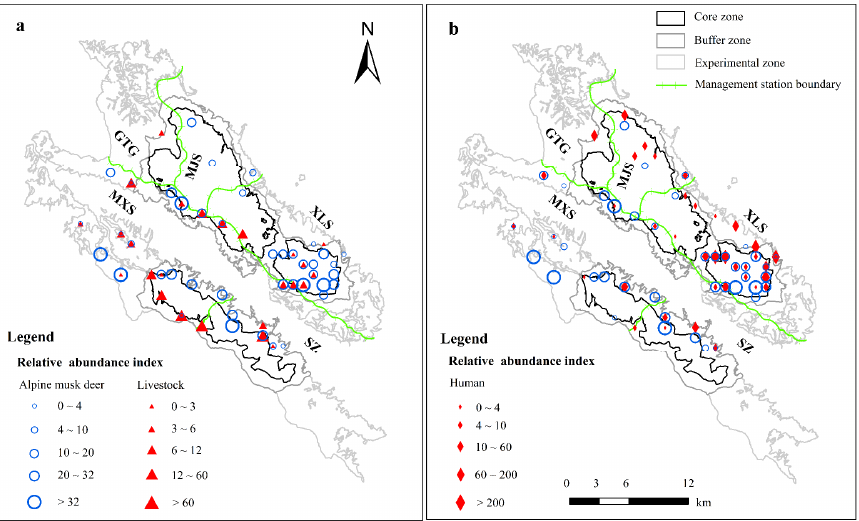
Figure 2. The species captured at coordinate locations in XMNNR ( a ) AMD and livestock ( b ) AMD and human.